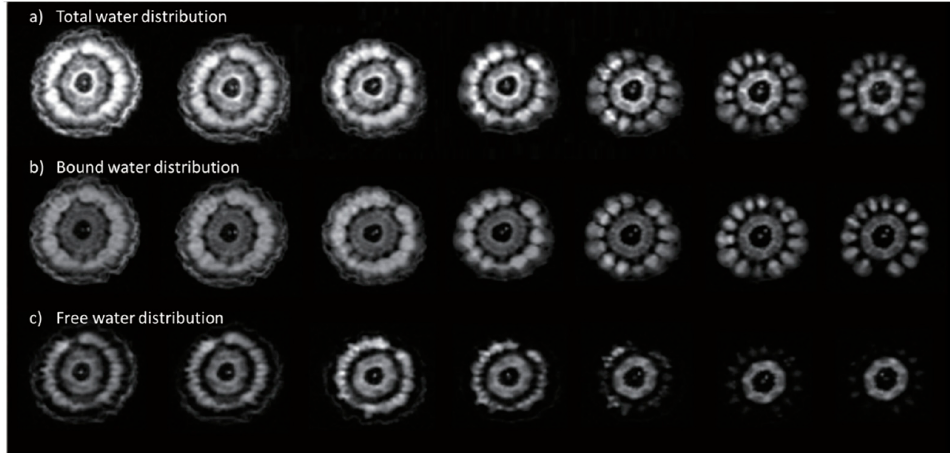
Figure 14. Daily grayscale cross-sectional magnetic resonance images of fresh ear corn ( a ) total-water, ( b ) bound-water and ( c ) free-water, (i.e., expressed as light color intensity) over a week-long drying process. Modified from Wang et al. [25] .